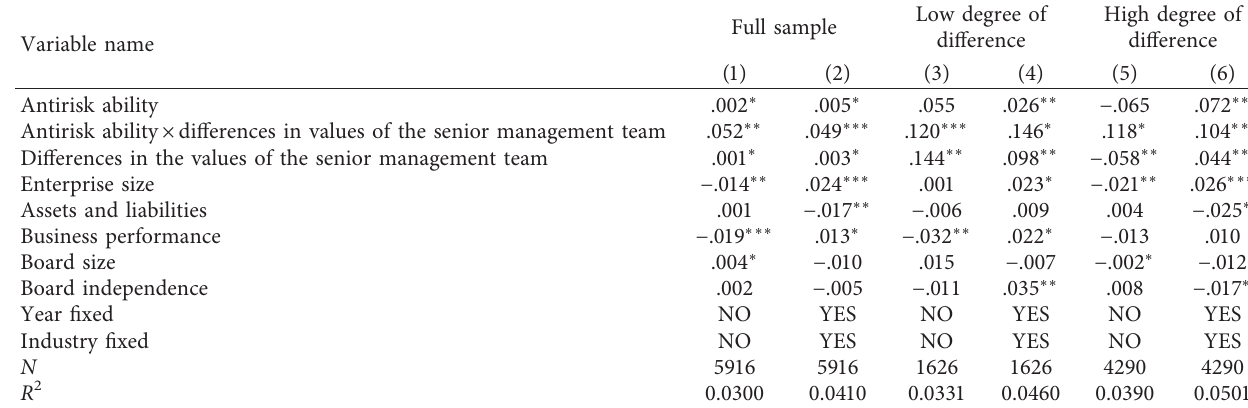
Table 7: Tests on the moderating effects of the differences in senior Management’s values against risks and innovation